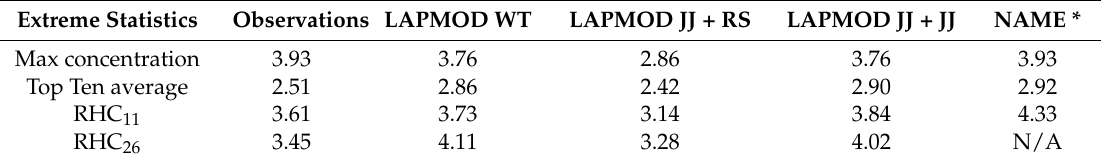
Table 6. Extreme statistics for the Kincaid SF 6 best-quality observations ( µ g m − 3 ). Extreme